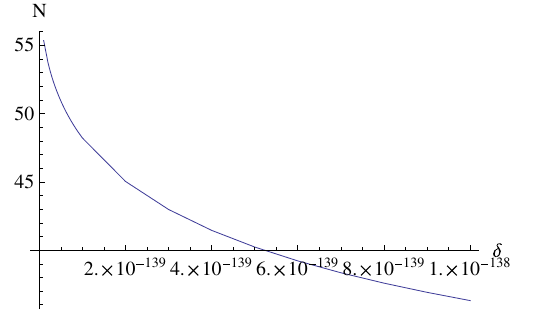
Fig. 10 The diagram presents the relation between the number of e- folds N and the parameter δ . The parameter δ is given in s 4 Mpc 4 assume that γ = 1 . 16 × 10 − 69 s 2 Mpc 2 10 − 32 s [38]